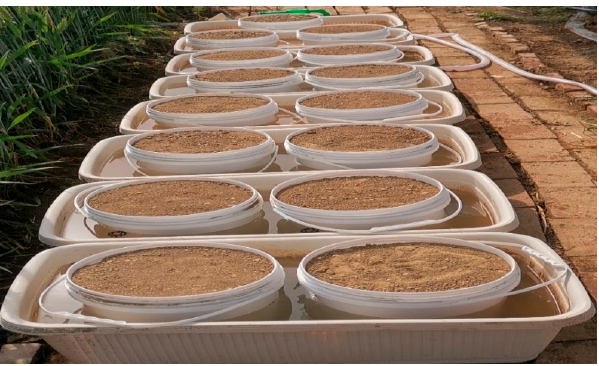
Figure 1. The splitting sunlight technology used polymer multilayer films to separate sunlight ( a ) The spectrum of the individual polymer films and ( b ) the spectrum of the combined polymer films.